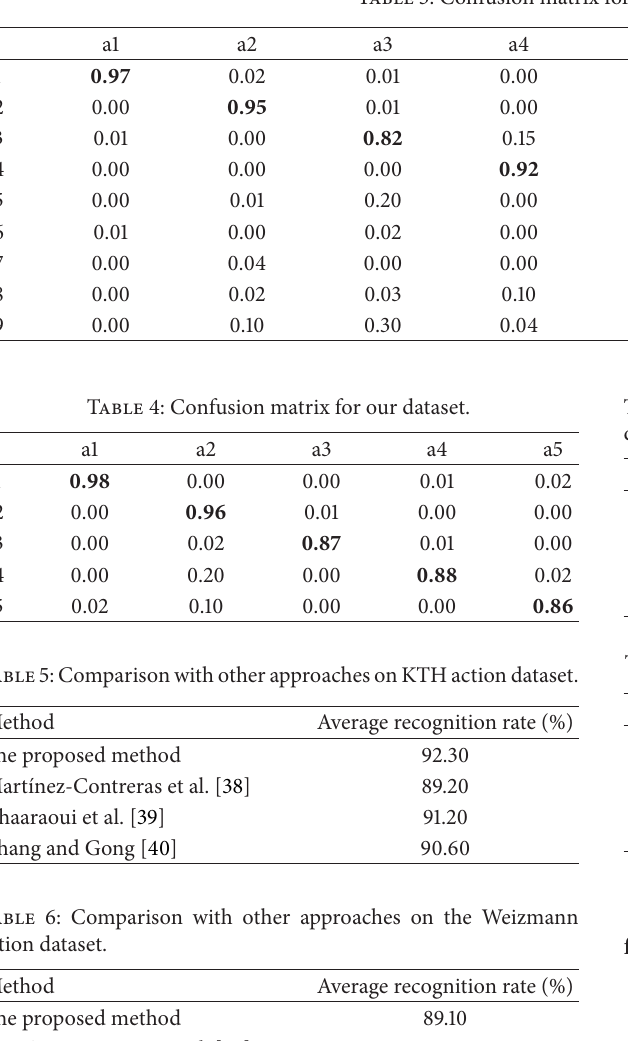
Table 3: Confusion matrix for the UCF sports dataset.